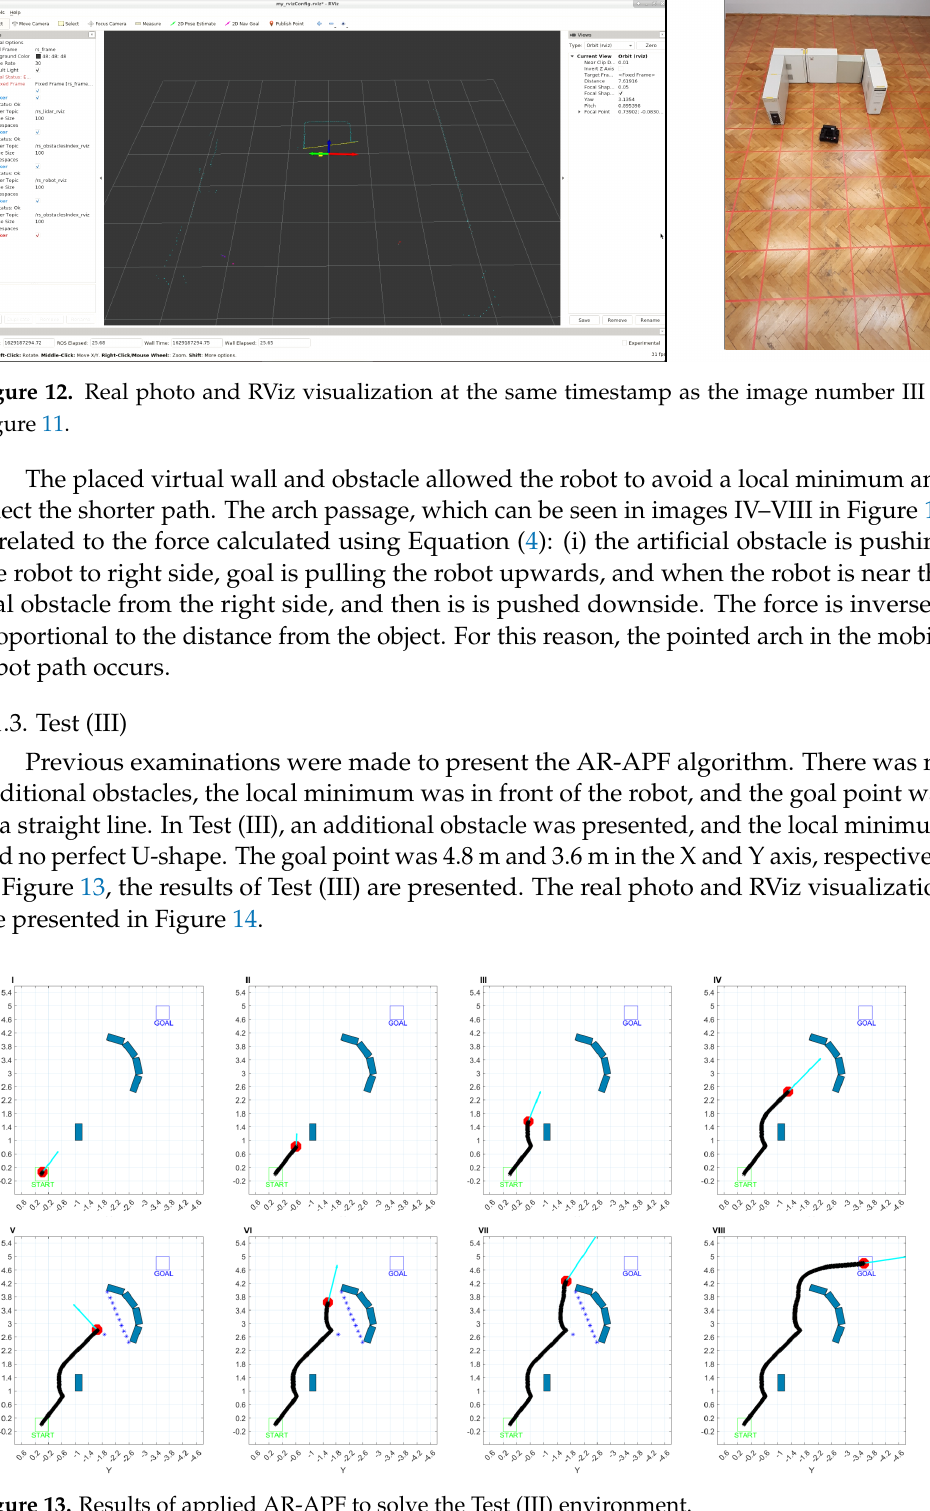
Figure 13. Results of applied AR-APF to solve the Test (III)